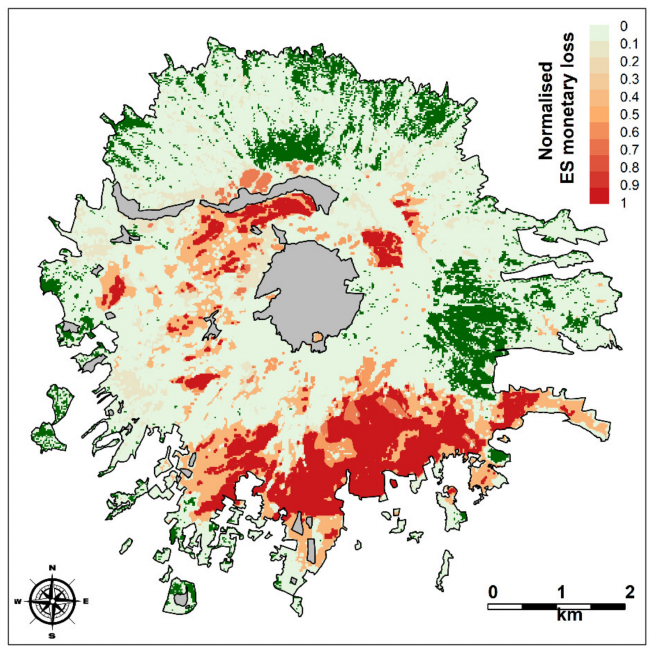
Figure 6. Normalised ES loss map. Gradient colours from light green to dark red represent the normalised monetary loss. The dark green polygons are unburnt forest surface whereas the grey polygons represent non-forested areas (i.e., the main volcano cone, secondary adventitious cones, and lava